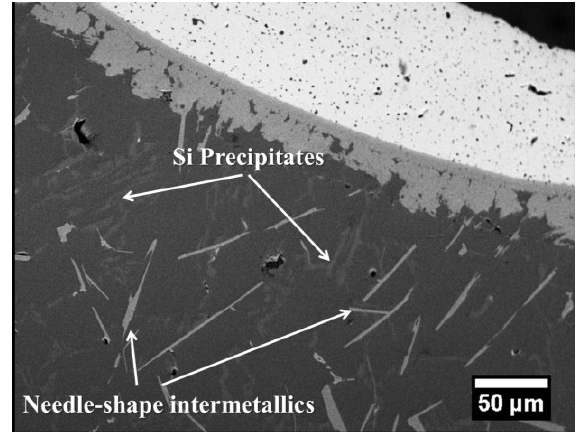
Figure 9. Backscattered SEM image of needle-shape intermetallics and Si precipitates in Al-S CMF sample made with 3.7 mm.